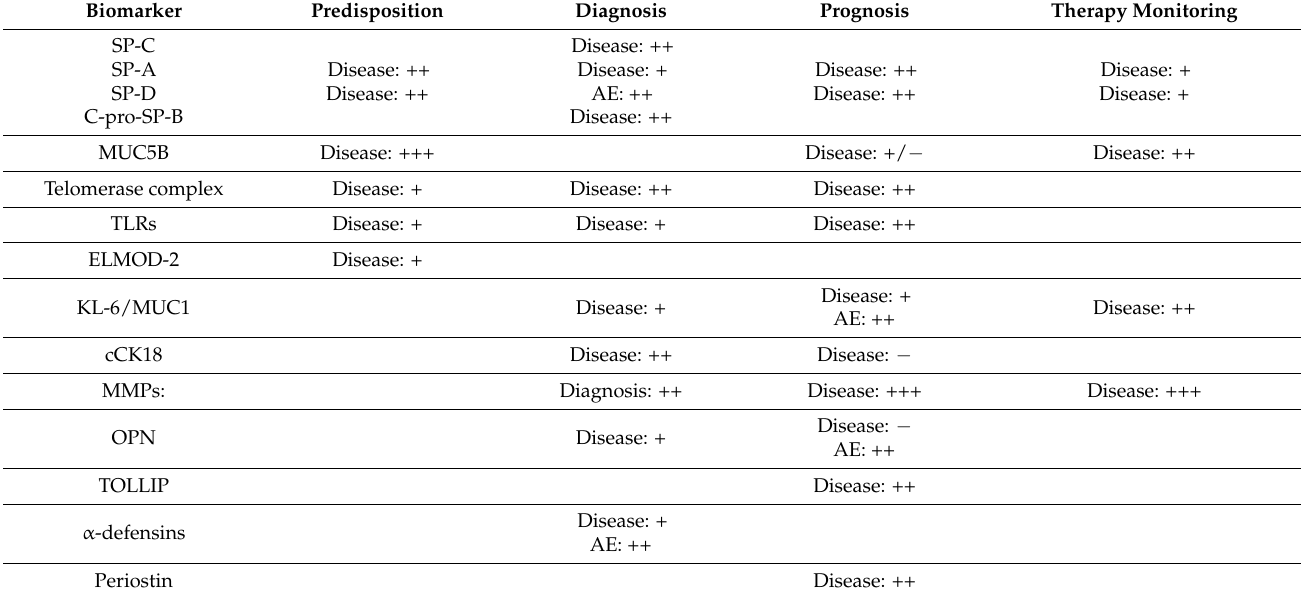
Table 1. Molecular biomarkers in IPF.